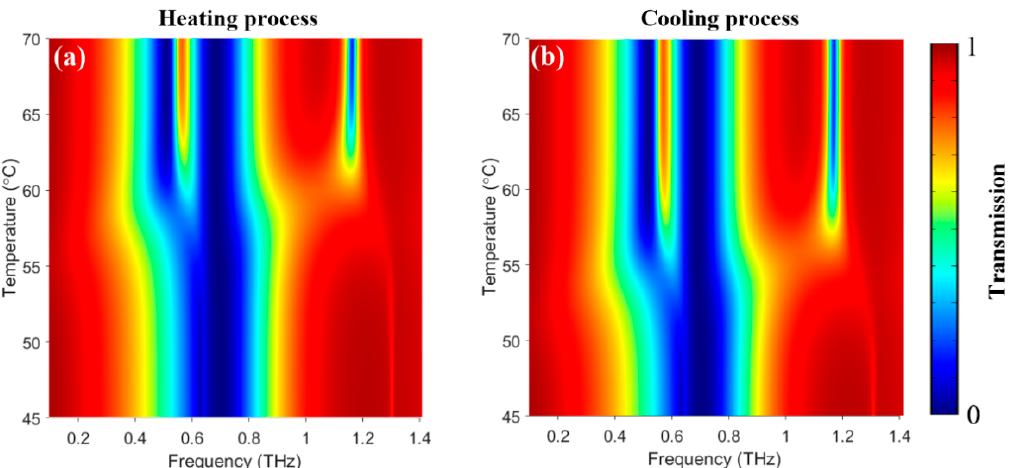
Figure 4. Two-dimensional graph of simulated THz transmission spectra corresponding to frequency and temperature of the proposed VO 2 -implanted MM structures, describing the continuously tunable process of Fano 1 and Fano 2: ( a ) heating process; ( b ) cooling process.